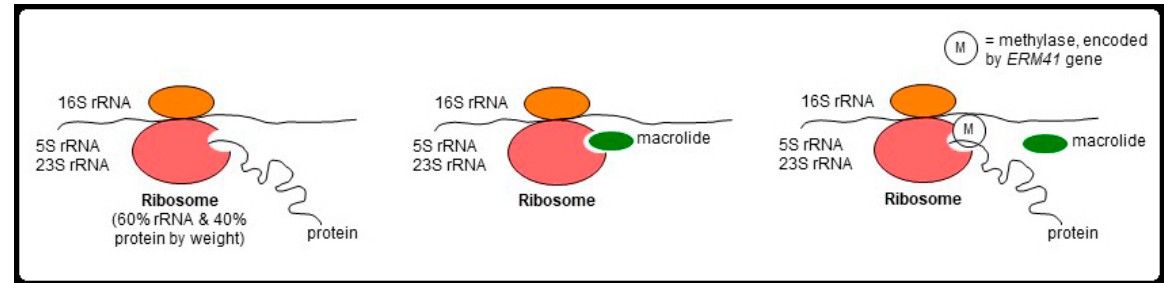
10 of 26 Figure 3. A schematic representation of M. abscessus current treatment protocol. Macrolides target bacterial 23S rRNA, inhibiting bacterial protein synthesis. M. abscessus possess two major forms of macrolide resistance, and both involve the bacterial 23S rRNA by different mechanisms. The first is “genetic” macrolide resistance and is due